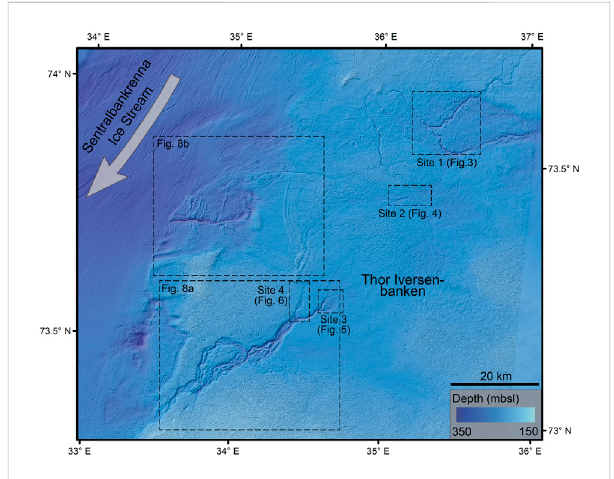
FIGURE 2 Shaded relief map created from the MAREANO bathymetric